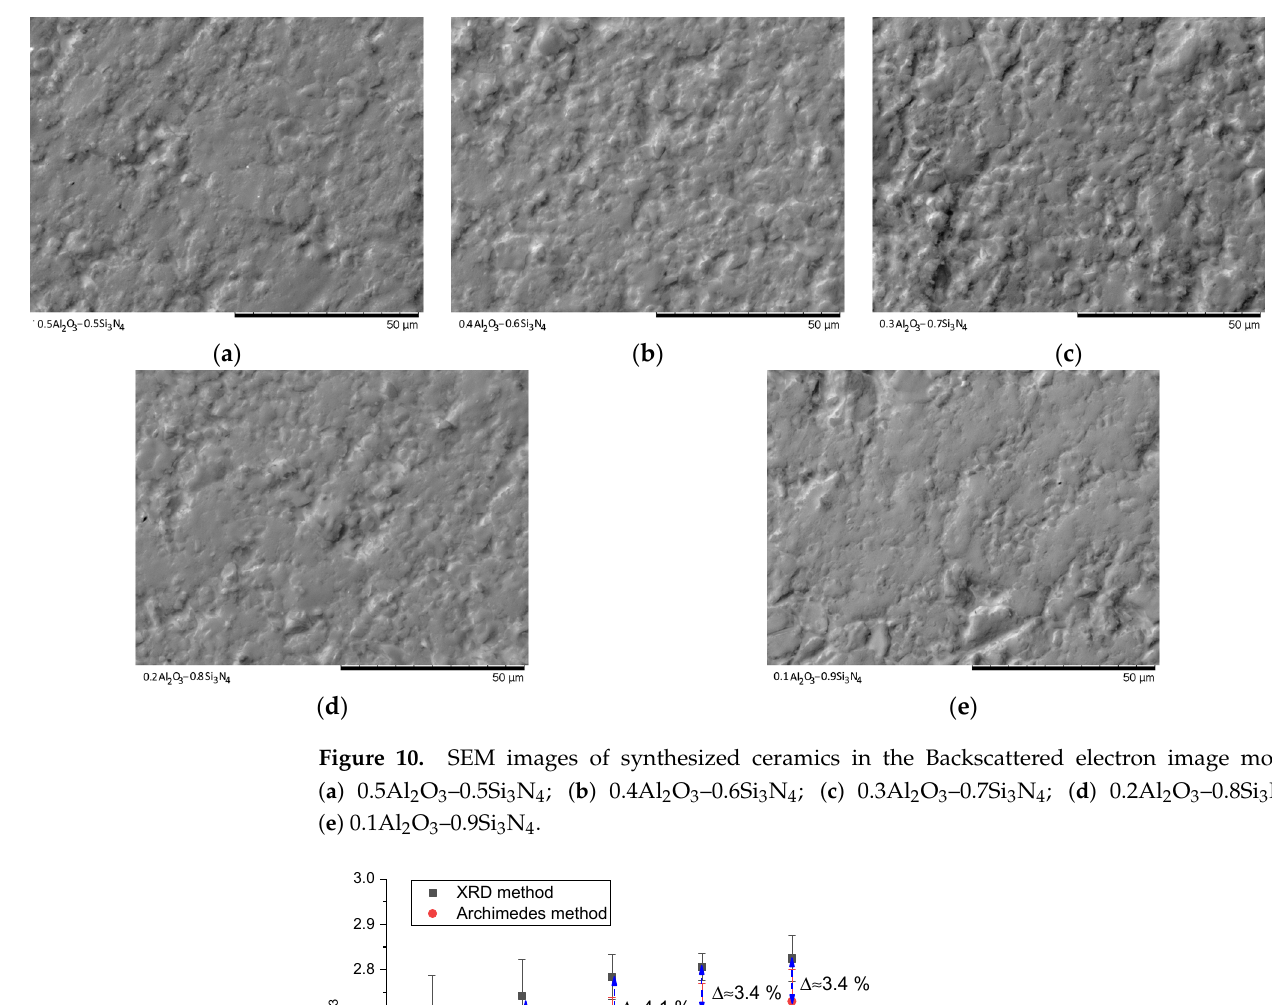
Figure 9. SEM images of synthesized ceramics in Secondary electron image mode: ( a ) 0.5Al 2 O 3 –